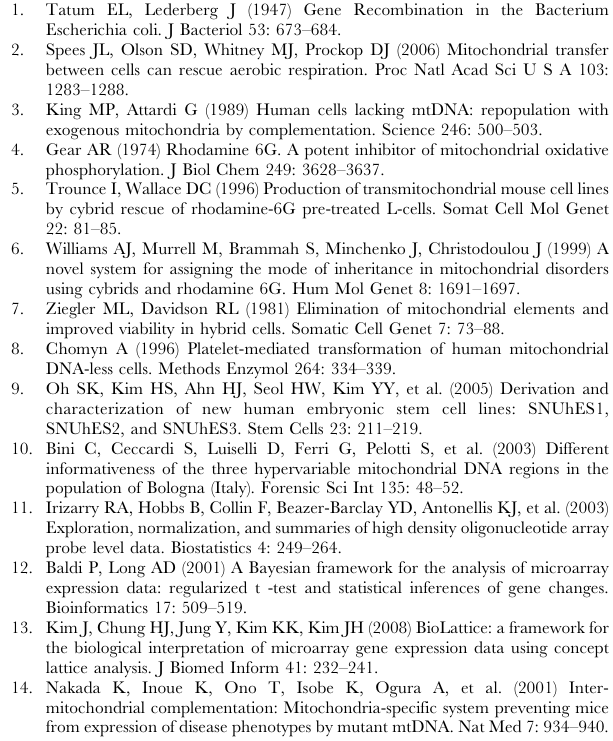
Table S6 GO annotations with P-value , 0.0001 in C12 of 4 6 4 clusters by SOM clustering. Table S7 GO annotations with P-value , 0.0001 in C13 of 4 6 4 clusters by SOM clustering. Table S8 GO annotations with P-value , 0.0001 in C15 of 4 6 4 clusters by SOM clustering. Table S9 GO annotations with P-value , 0.0001 in C16 of 4 6 4 clusters by SOM clustering. Table S10 Prominent sub-lattice analysis of a concept lattice shown in Fig. S3. Table S11 Core-periphery analysis of a concept lattice shown in Fig. S3.